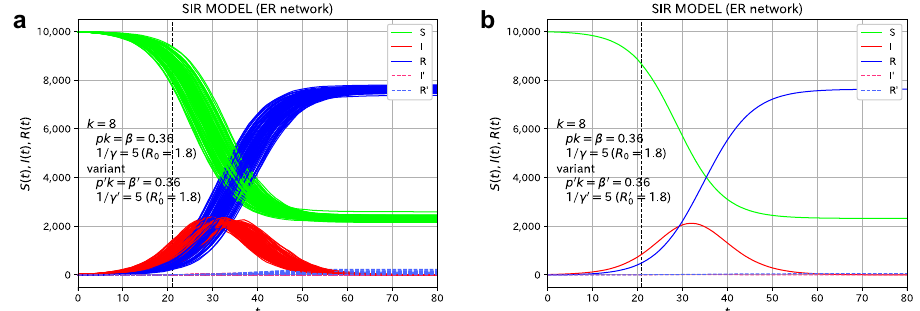
Figure 4. Effects of variants for the spread of the epidemic disease on the ER network. Suppose that 10 individuals are infected with the original virus ( R ′ 0 = 1.8 ) by an external factor at t = 21 . ( a ) The plot of all 100 samples. ( b ) The average of the 100 samples. The red and blue dashed lines are additional values.